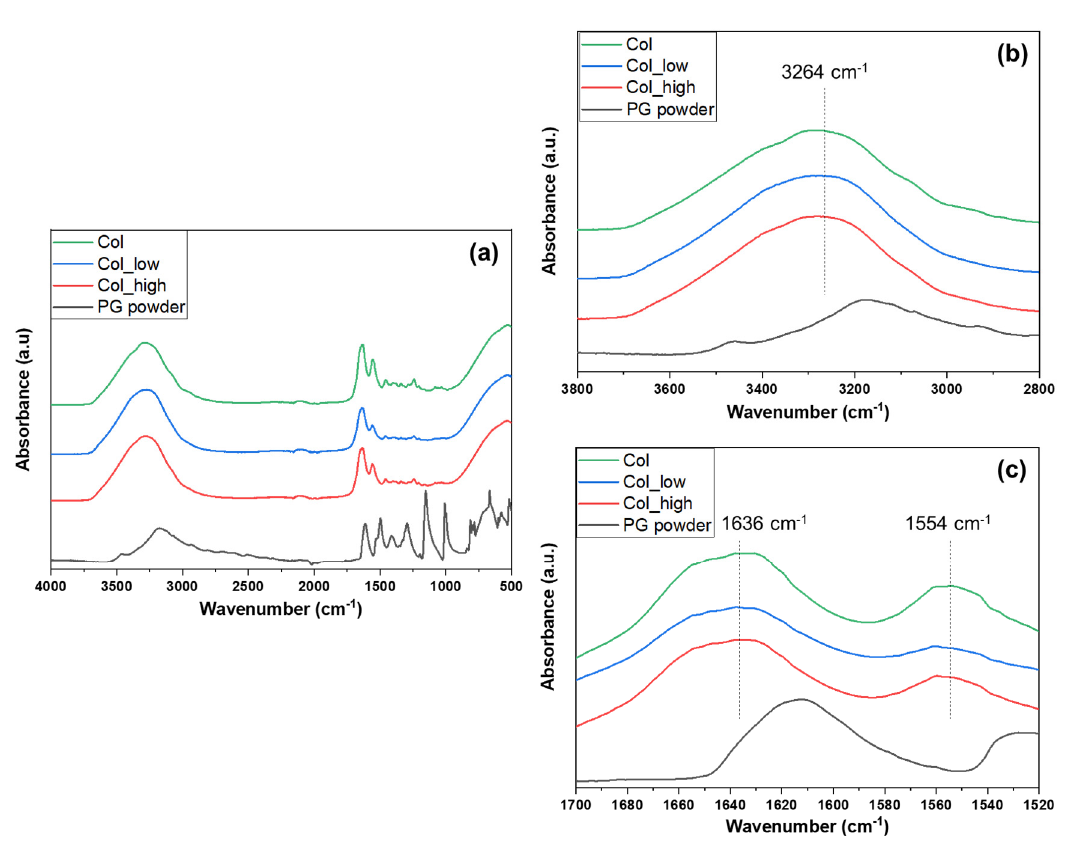
Figure 1. FTIR spectra of PG powder and collagen hydrogels containing no PG, 0.333 mg / mL and 1.0 mg / mL of PG solutions ( a ) in the 4000–500 cm − 1 , ( b ) in the 3800–2800 cm − 1 and ( c ) in the 1700–1520 cm − 1 wavenumber regions. Col: collagen hydrogel; Col_low: collagen hydrogel with a “low” PG concentration (0.333 mg / mL); Col_high: collagen hydrogel with a “high” PG concentration (1.0 mg / mL).